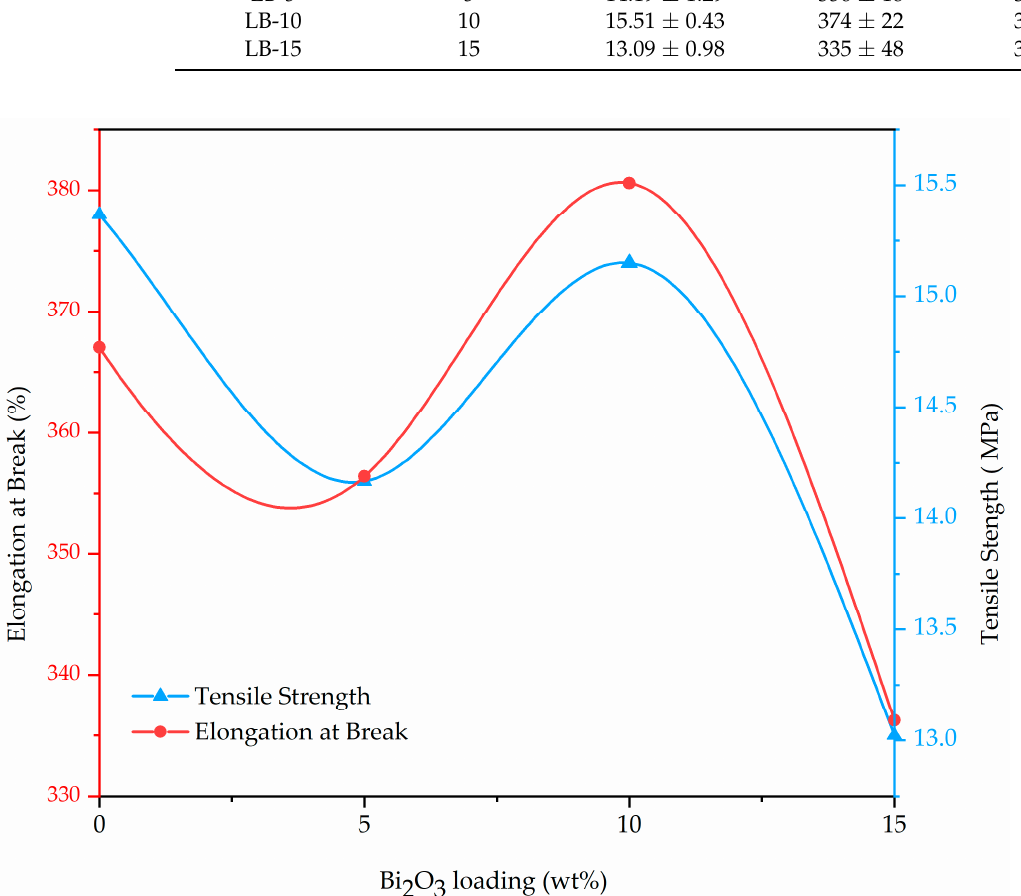
Figure 2. Effect of wt% of Bi 2 O 3 on the mechanical properties of LDPE.